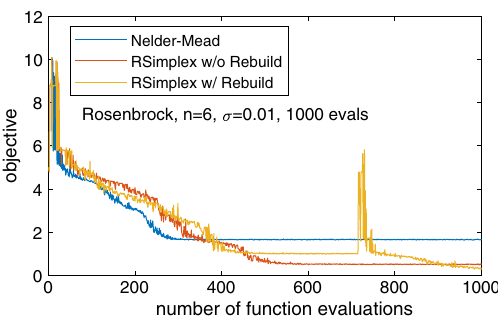
FIG. 2. History of the objective function values of all evaluated solutions for the Rosenbrock function optimization problem using three algorithms: Nelder-Mead simplex (blue line), RSim- plex w/o simplex rebuilding (red line), and RSimplex w/ simplex rebuilding (yellow